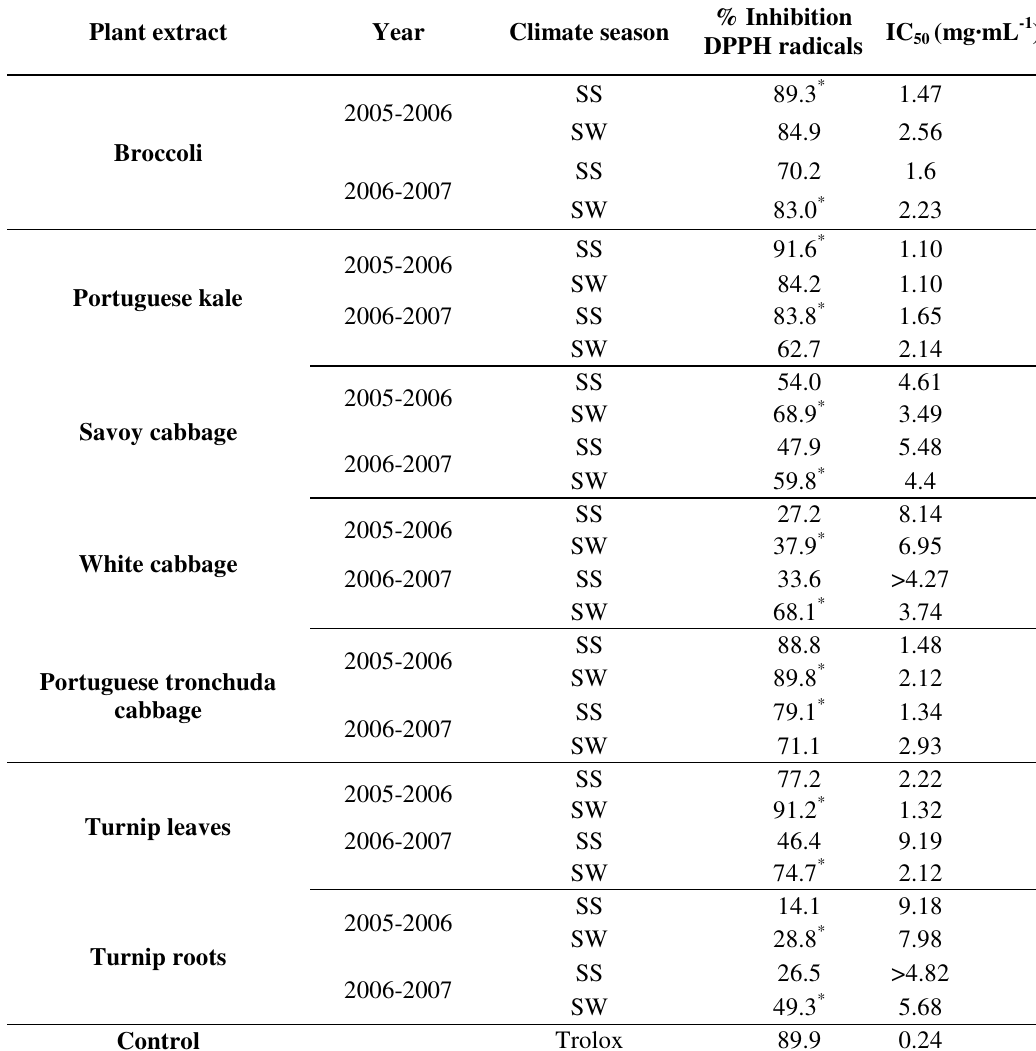
Table 4. % Inhibition of DPPH radicals at 5 mg·mL –1 and IC determined from the dose-curve response for each plant extract in two consecutive years and two different climate seasons [Spring-Summer (SS) and Summer-Winter (SW)].